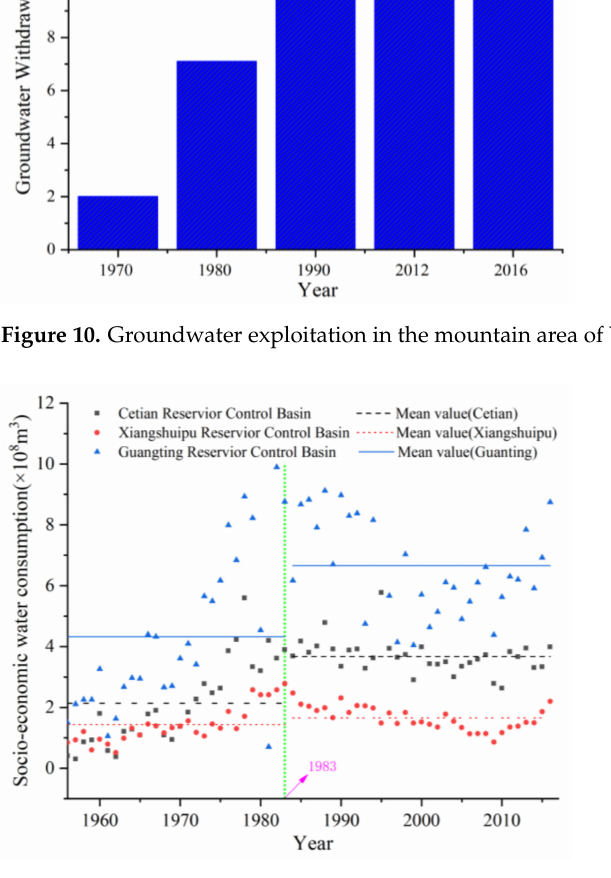
Figure 11. Socioeconomic water consumption in the mountain area of Yongding River from 1956 to 2016.